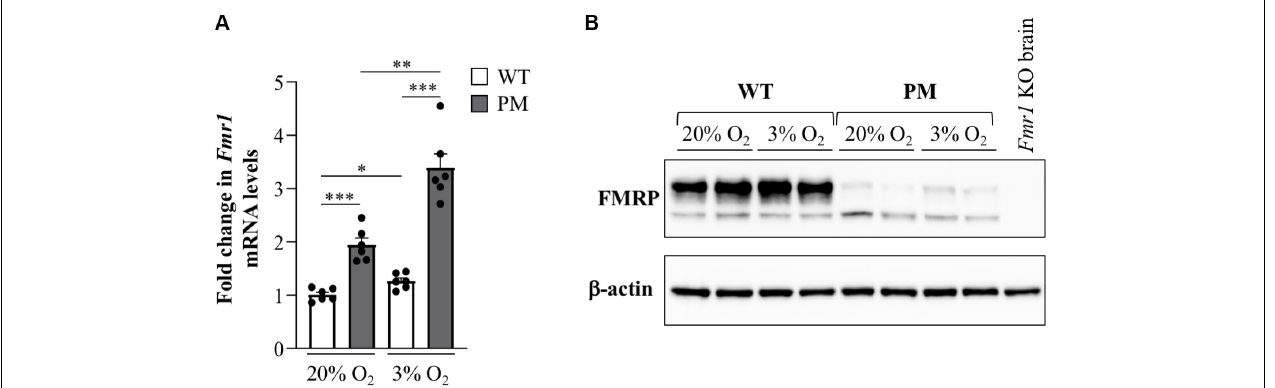
FIGURE 5 | Fmr1 expression in FX PM mESCs. (A) Quantitative reverse-transcription-PCR analysis of Fmr1 expression in WT and PM lines cultured at 20% or 3% O 2 using β -actin for normalization. Values are relative to the average expression of the WT lines cultured at 20% O 2 . Results are from 3 mESC lines for each condition and represented as mean ± SEM. n = 6; * p < 0.01; ** p < 0.001; and *** p ≤ 0.00001. (B) Western blot analysis of FMRP expression in 2 WT and 2 PM lines cultured at 20% or 3% O 2